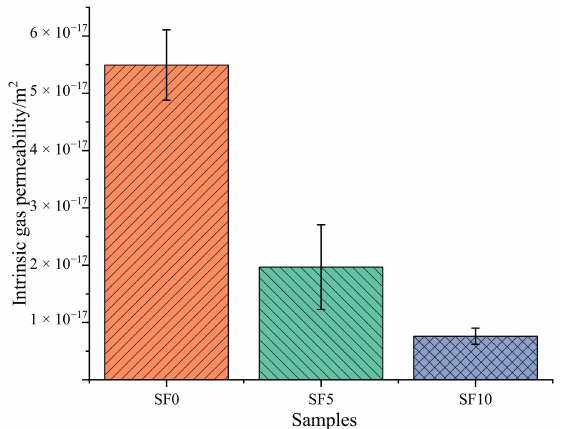
Figure 2. Intrinsic gas permeability of mortar samples with different mixing